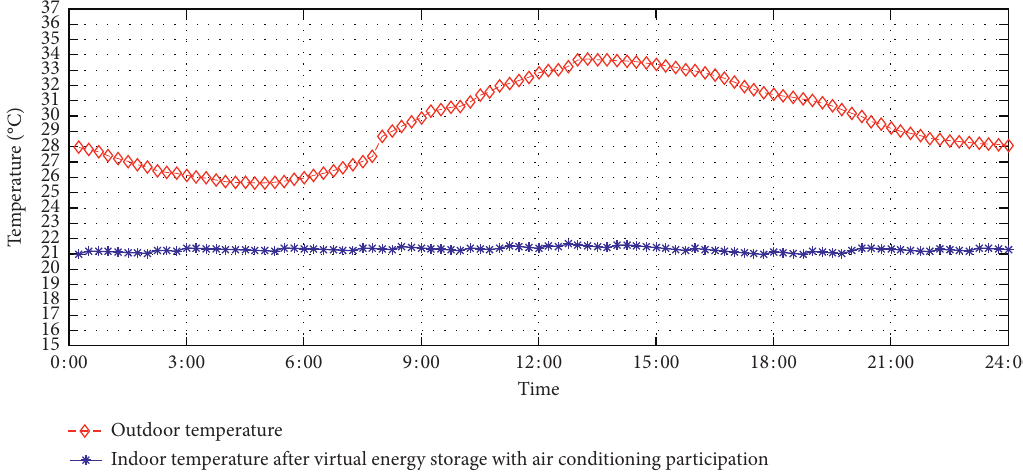
Figure 13: Comparison of indoor and outdoor temperature change curves.